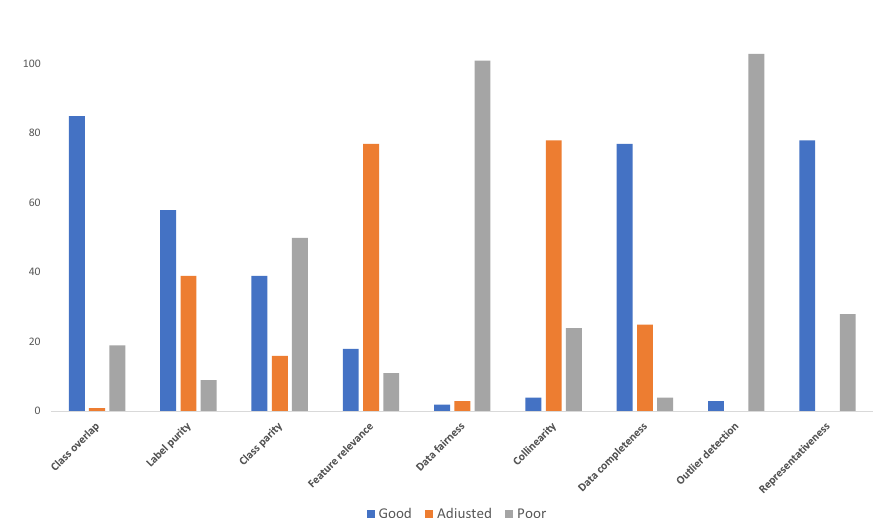
Fig. 3 Distribution of structured datasets according to the data quality assessment